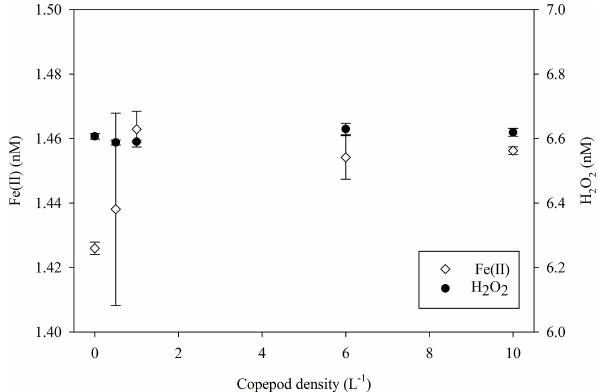
Figure 8. H 2 O 2 and Fe(II) concentrations in a culture of diatoms growing in coastal seawater after 20h of incubation with a zoo- plankton gradient imposed by addition of copepods. Error bars show ± SD of triplicate